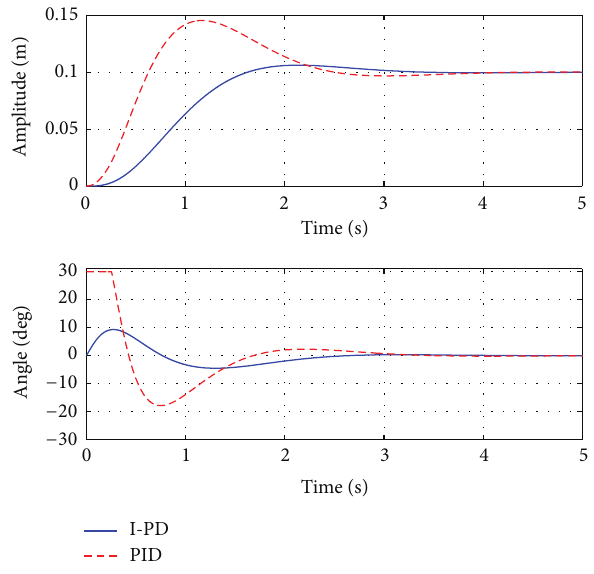
Figure 9: Step response simulation results.